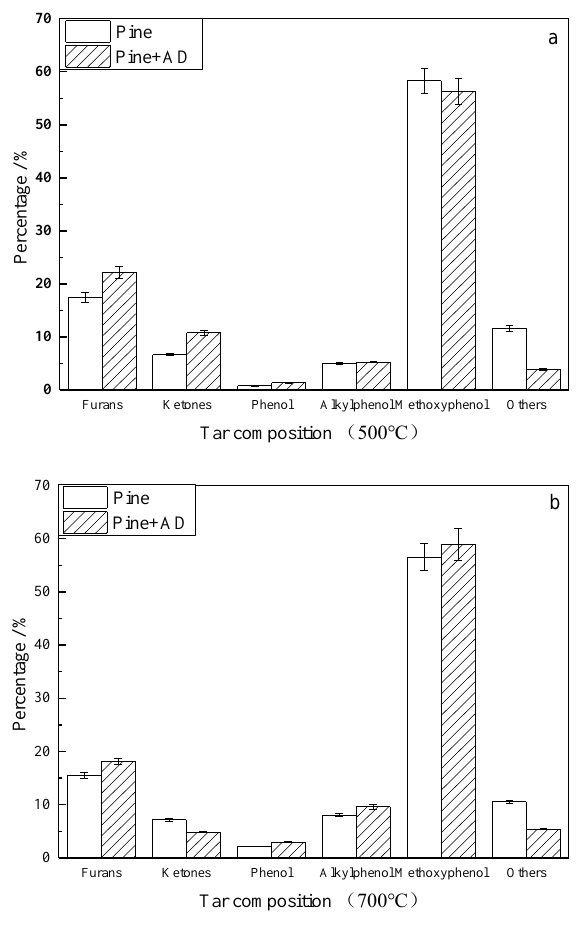
Figure 8. Comparison of the tar composition from the pyrolysis of pine and a mixture at 500 °C and 700 °C: ( a ) 500 °C and ( b ) 700 °C .